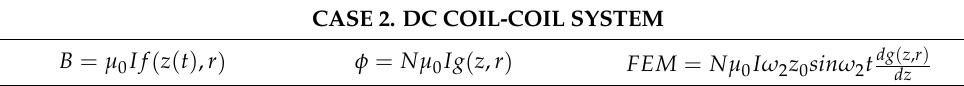
Table 2. Summary table of equations, case